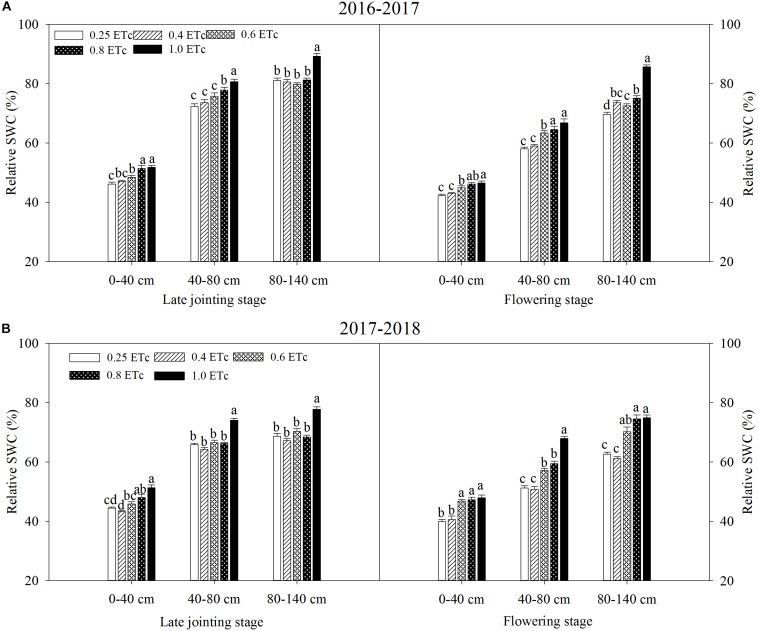
Relative soil water content at different growth stages under different drip irrigation treatments during 2016–2017 (A) and 2017–2018 (B) growing season. Vertical bars represent standard errors (n = 4). Different lowercase letters above the bars in the same growing stage are significantly different among different treatments at P < 0.05. The 0.25, 0.4, 0.6, 0.8, and 1.0 ETc represents 25, 40, 60, 80, and 100% crop evapotranspiration, respectively.